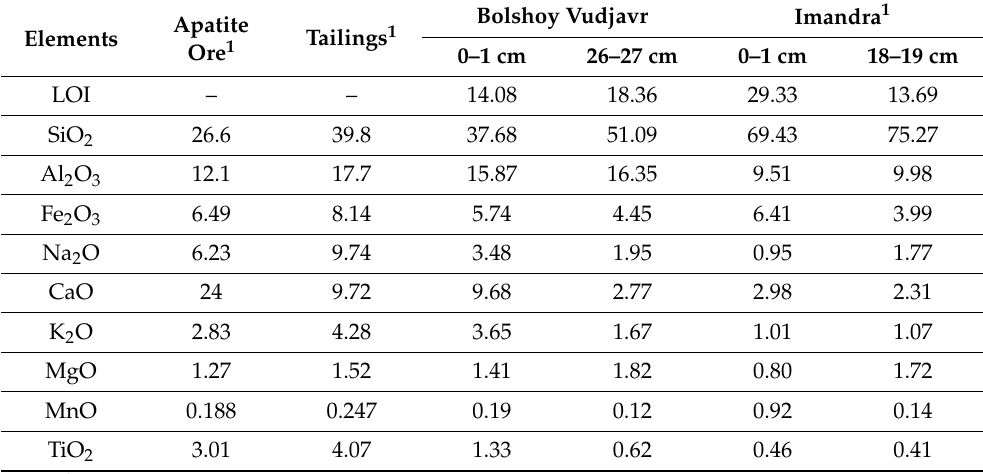
Table 1. The content of organic matter (LOI) and macroelements (in %) in apatite ore, tailings of apatite production, and surface and background layers of sediments in lakes Bolshoy Vudjavr and Imandra according to the results of X-ray fluorescence analysis.